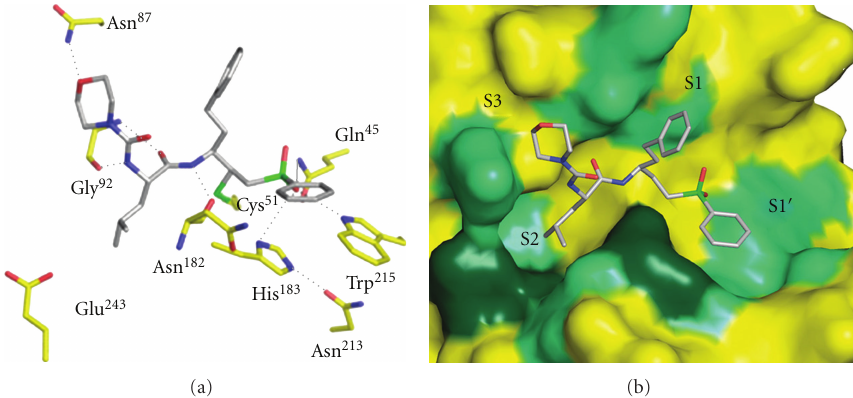
Figure 11: (a) Interaction of falcipain-3 with morpholinourea-leucine-homophenylanyl-phenyl vinylsulfone (Mu-Leu-Hph-VsPh). The residues in the active site of falcipain-3 are colored yellow and labeled, and morpholinourea-leucine-homophenylanyl-phenyl vinylsulfone is colored gray. The interactions with enzyme and inhibitor are in black dots. (b) The active site of falcipain-3 with hydrophobic environment. The inhibitor occupies the S1 (cid:3) , S1, S2, S3 subsites of enzyme. Hydrophobic residues are colored light green, and polar residues that interact with the inhibitor by nonpolar C–C bonds are colored dark green